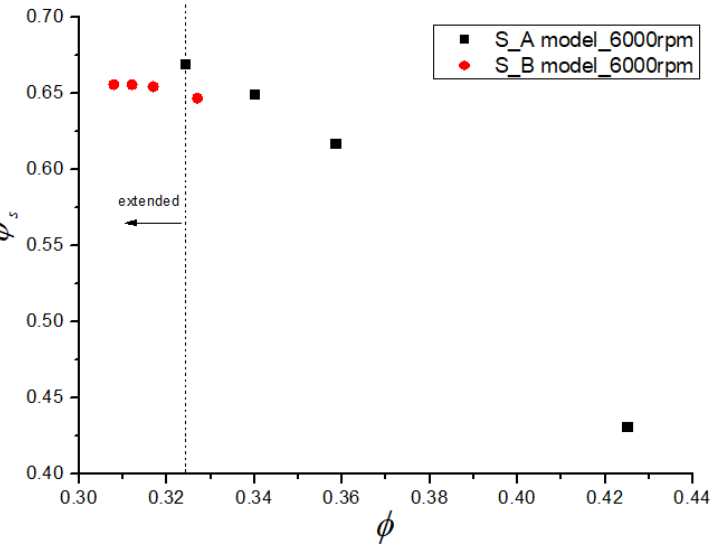
Figure 11. Performance near-stall points with the S_A and S_B models.